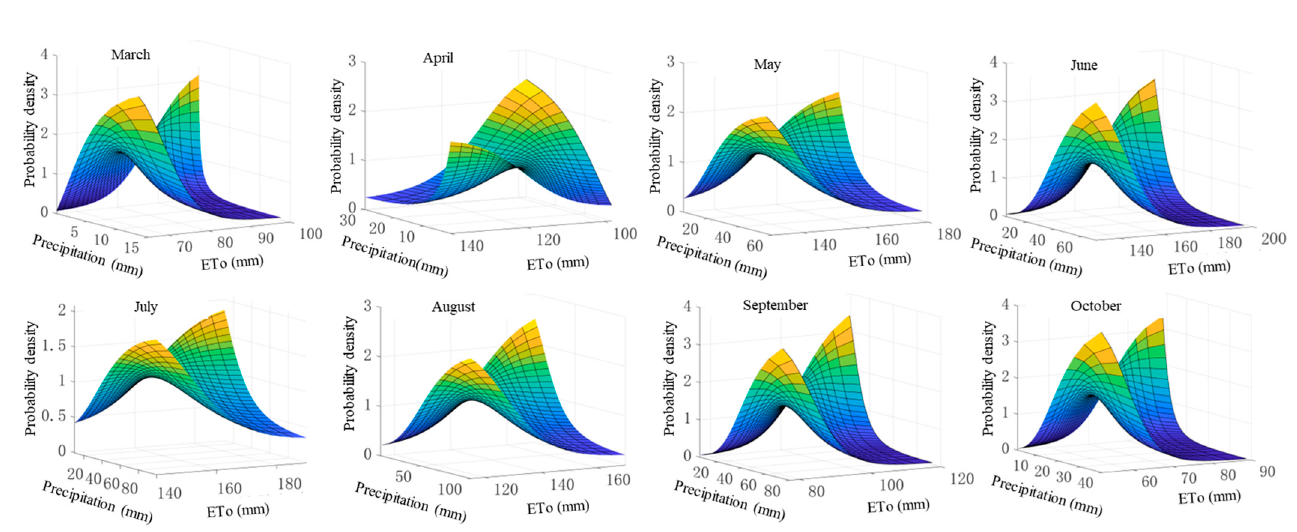
Table 4. Parameters of marginal distribution for monthly reference evapotranspiration.